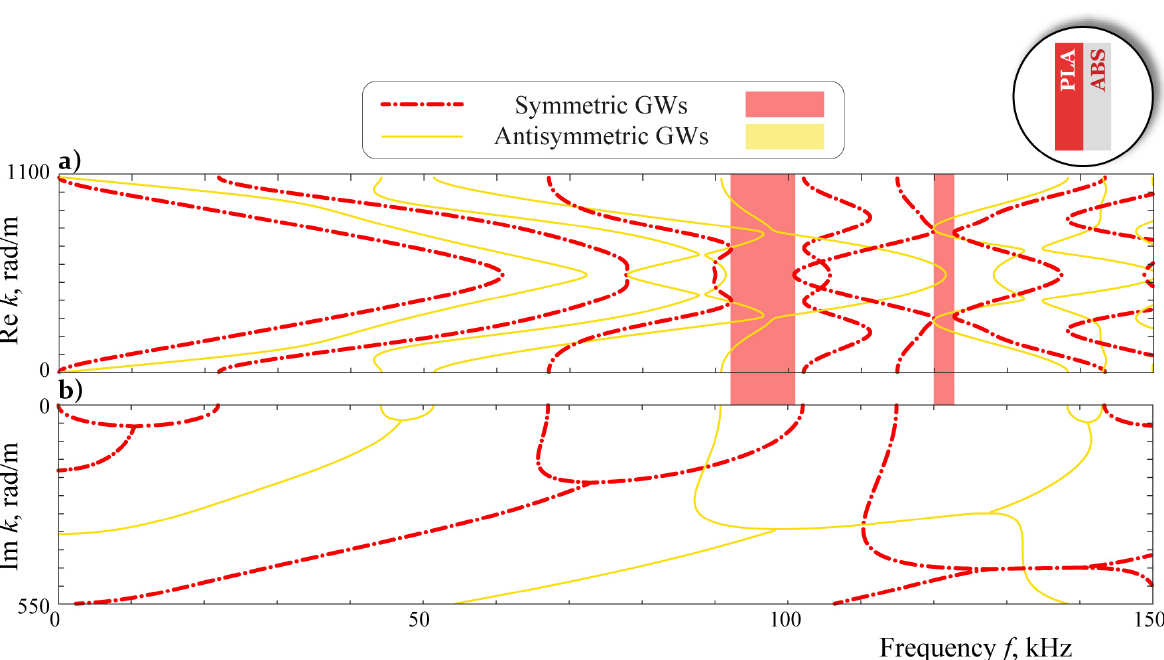
Figure 4. The real ( a ) and imaginary parts ( b ) of the wavenumbers of propagating symmetric and antisymmetric GWs propagating in AMM without